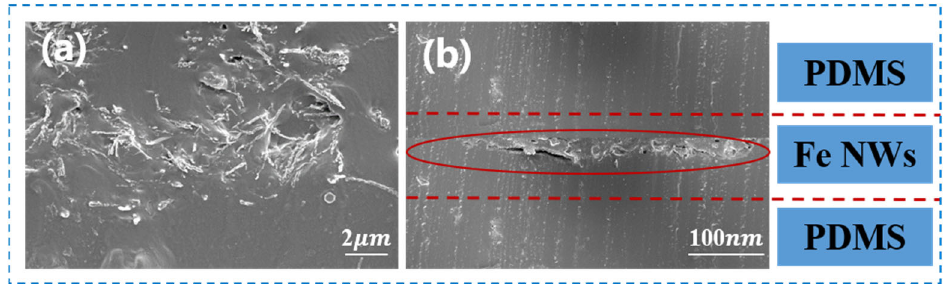
Figure 3. Characterization of Fe NW ‐ based sandwich strain sensor. ( a ) Cross ‐ section; ( b ) longitudi ‐ nal